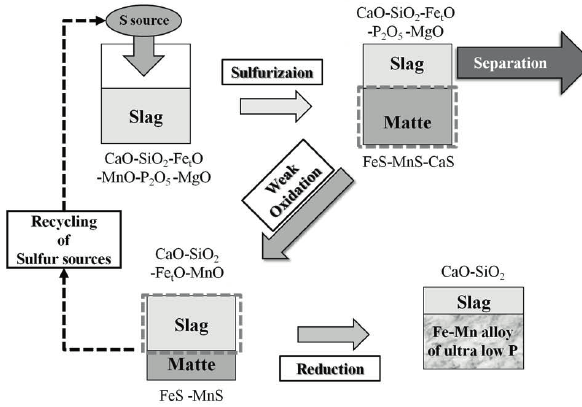
Figure 2. Schematic diagram for the proposed recycling process of Mn from slag.